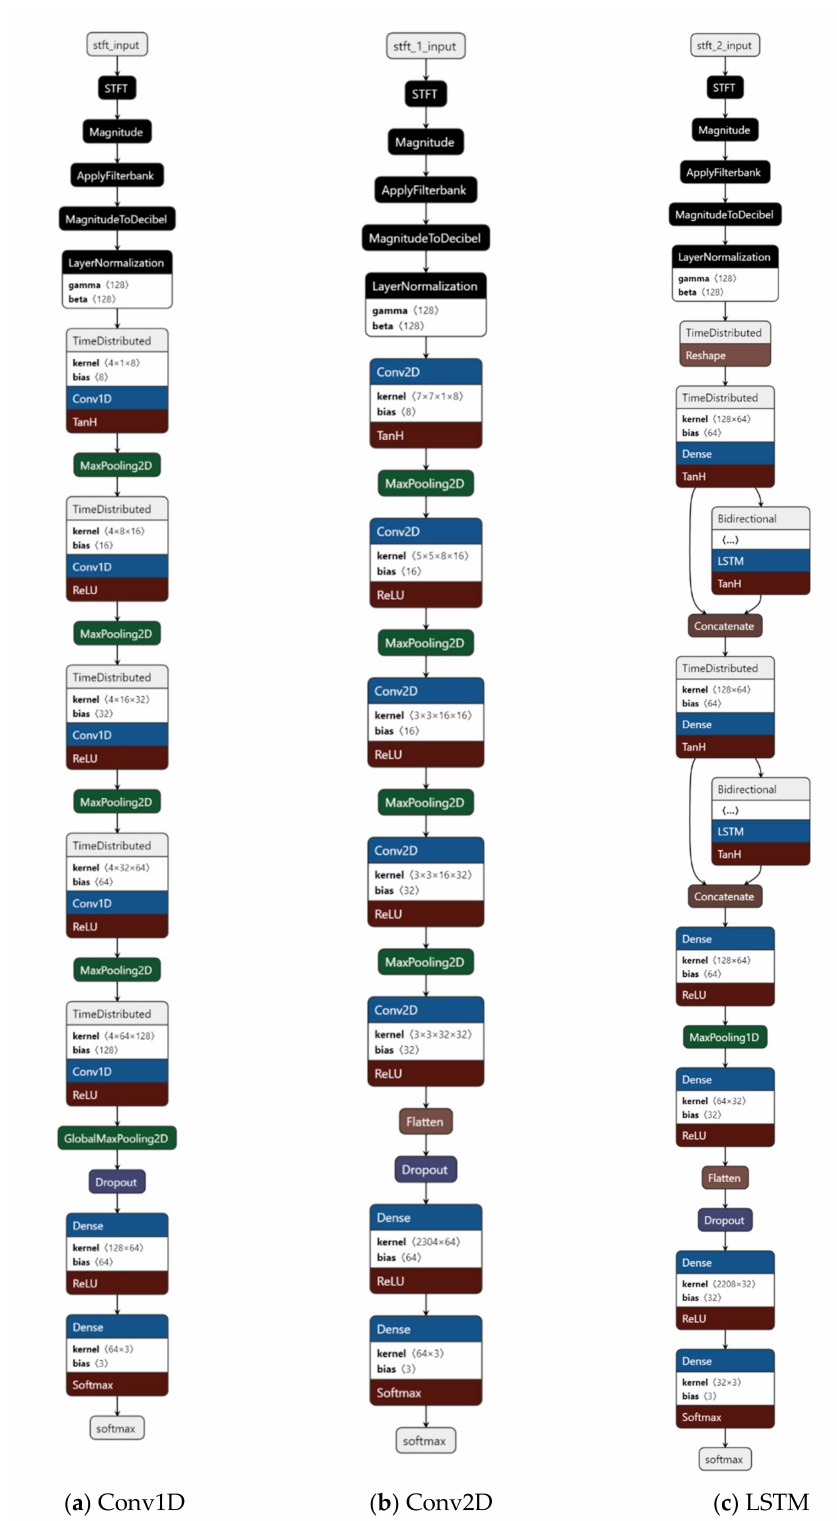
Figure 7. Architectures of the three proposed deep learning models for ingestive behavior classifica- tion. Conv1D represents one-dimensional convolutional neural network; Conv2D is two-dimensional convolutional neural network; LSTM represents long short-term memory network; and STFT is short-time Fourier